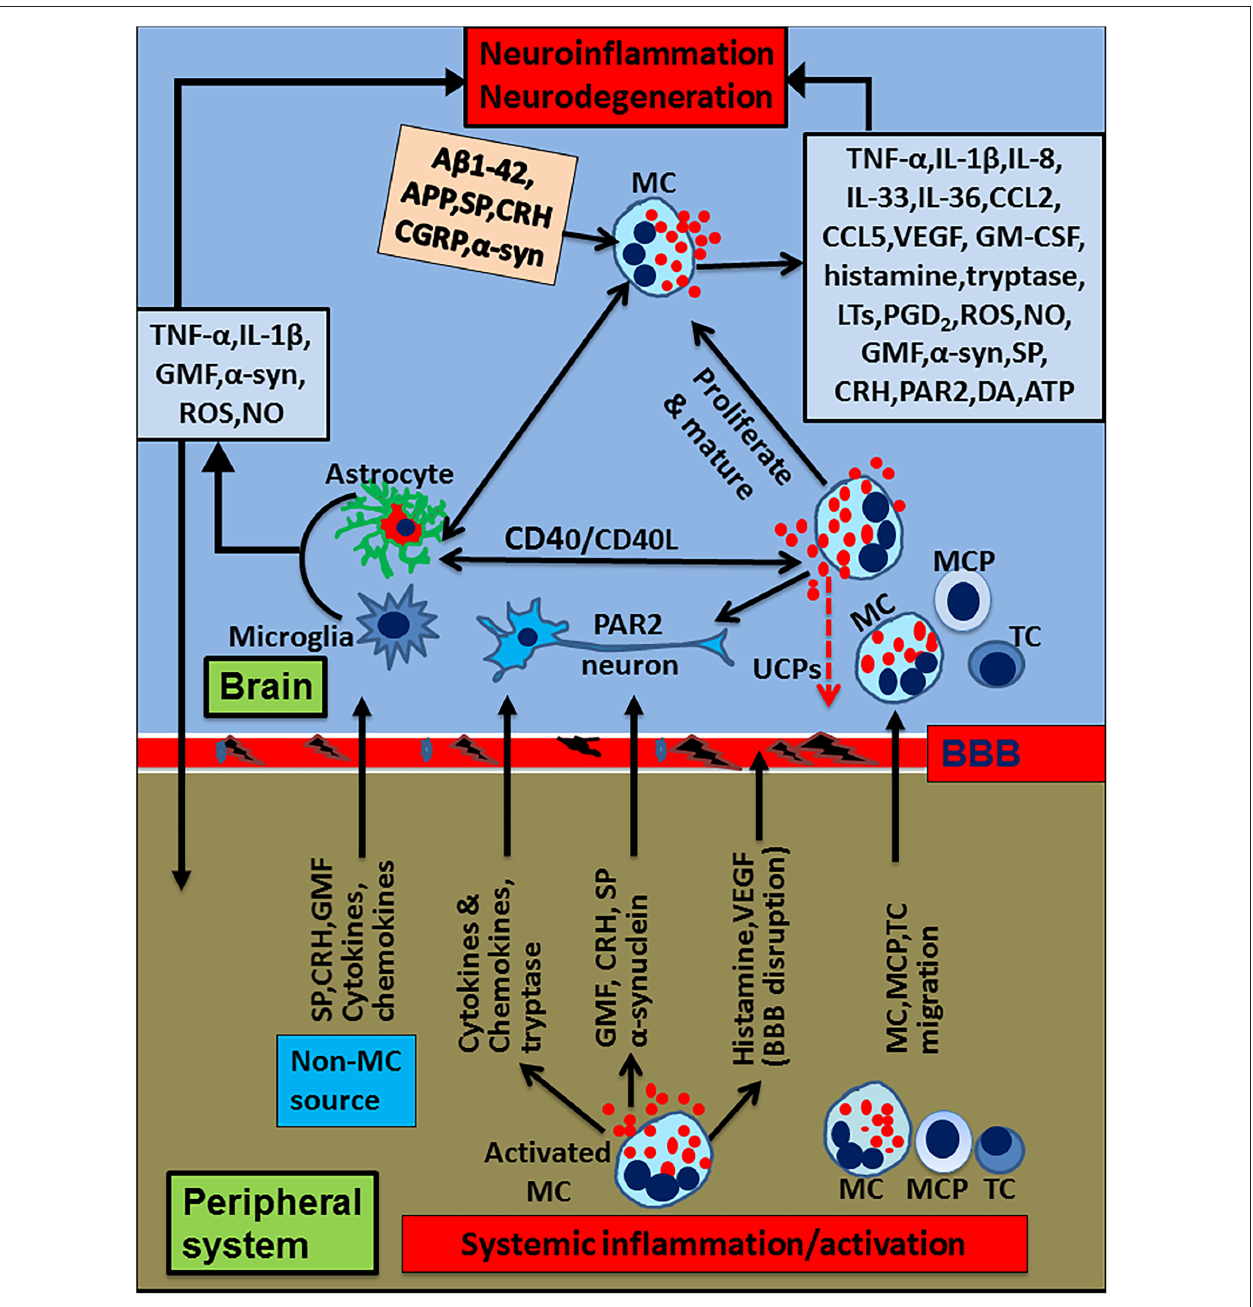
FIGURE 2 | Schematic diagram showing peripheral inflammatory factors and cells on neuroinflammation and neurodegeneration. Peripheral mast cell activation releases proinflammatory and neurotoxic mediators such as histamine, glia maturation factor (GMF), α -synuclein, corticotropin-releasing hormone (CRH), proteases, cytokines and chemokines. These mediators can induce neuroinflammation by inducing BBB breakdown, entering into the brain and activating glia and neurons to secrete various additional inflammatory mediators. Peripheral mast cells and T-cells enter into the brain, proliferate and secrete proinflammatory mediators that activate glia and neurons to secrete more inflammatory mediators, reduce uncoupling protein (UCP) expression, and induce neurodegeneration. Further, glia and mast cells reactivate each other in the brain through co-stimulatory molecules CD40/CD154 or inflammatory mediators such as TNF- α , IL-1 β or IL-33. Mast cell tryptase acts on the neurons through PAR2. Mast cells can reactivate by their own mediators in an autocrine and paracrine manner to exacerbate inflammatory mechanisms. α -synuclein or MPP + from glia/neuron or extracellular A β 1–42 can further activate mast cells to release neuroinflammatory mediators in Alzheimer’s disease (AD) or Parkinson’s disease (PD). Additionally several inflammatory mediators from the peripheral system can alter BBB, enter the brain and activate the neuroinflammatory pathways. Inflammatory mediators released from activated microglia and astrocytes can enter into peripheral system through defective BBB; then, they can activate and recruit immune and inflammatory cells towards the inflammatory site in the brain. MC, mast cell; MCP, mast cell progenitor; TC, T-cell; PAR2, protease activated receptor-2.